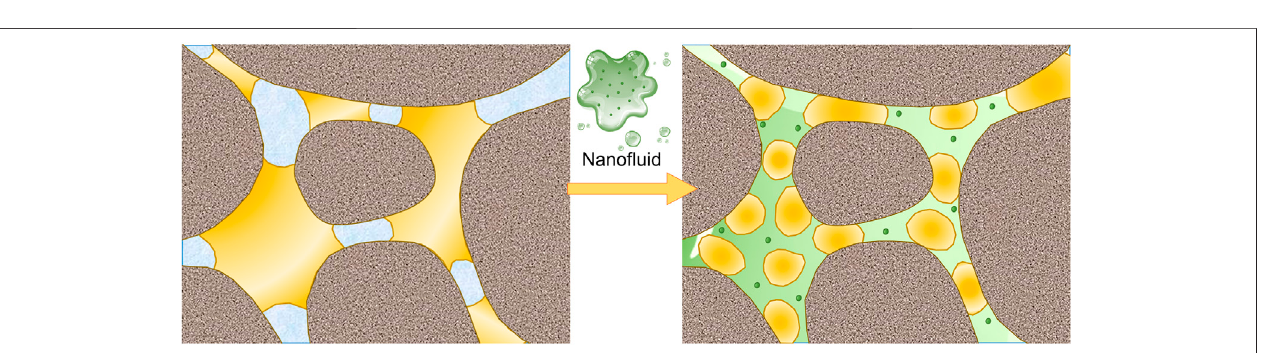
FIGURE 13 | Mechanism of nano fl uid ’ s enhancing oil permeation